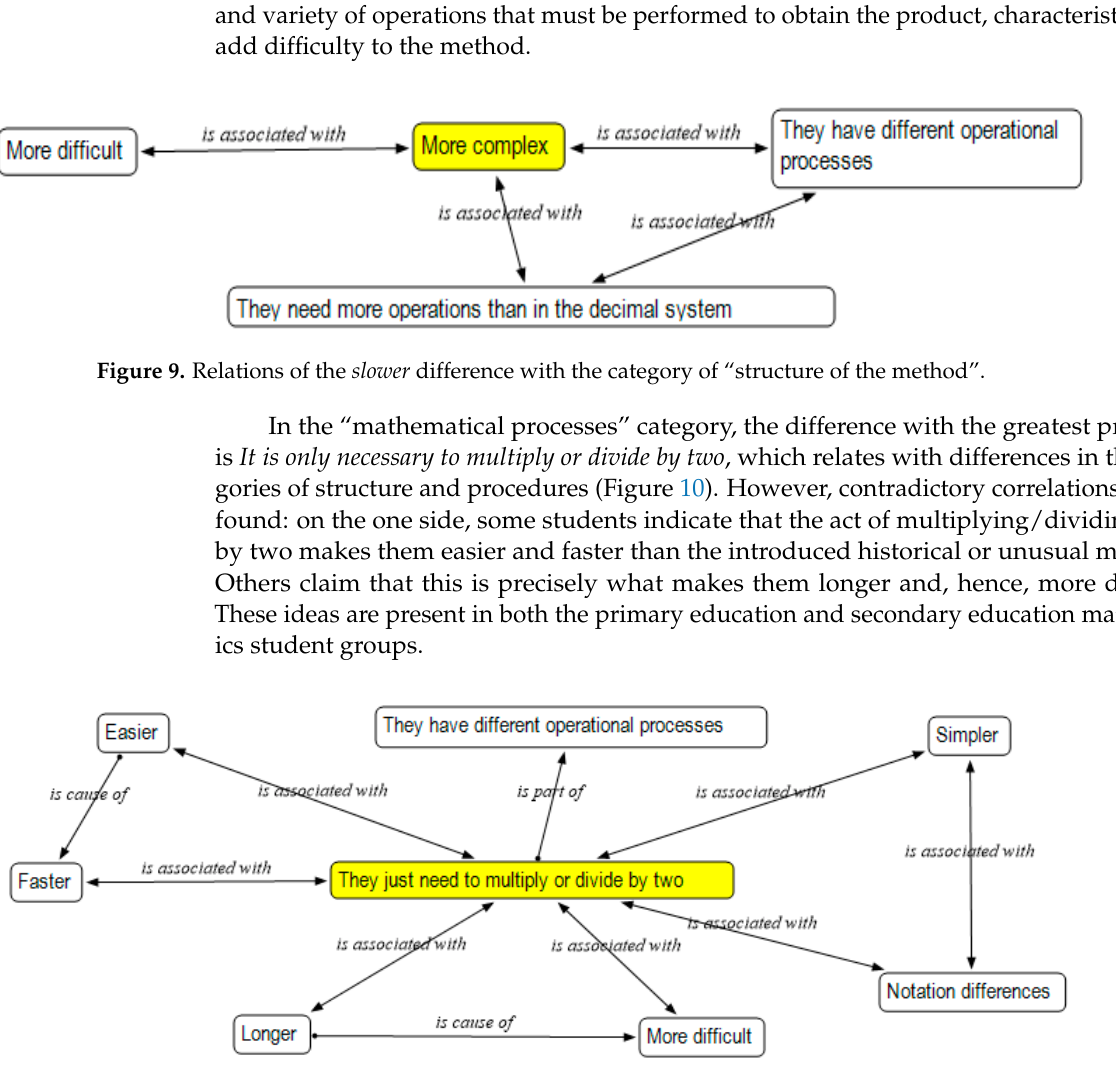
Figure 8. Relations of the slower difference with the categories of procedures and applications.